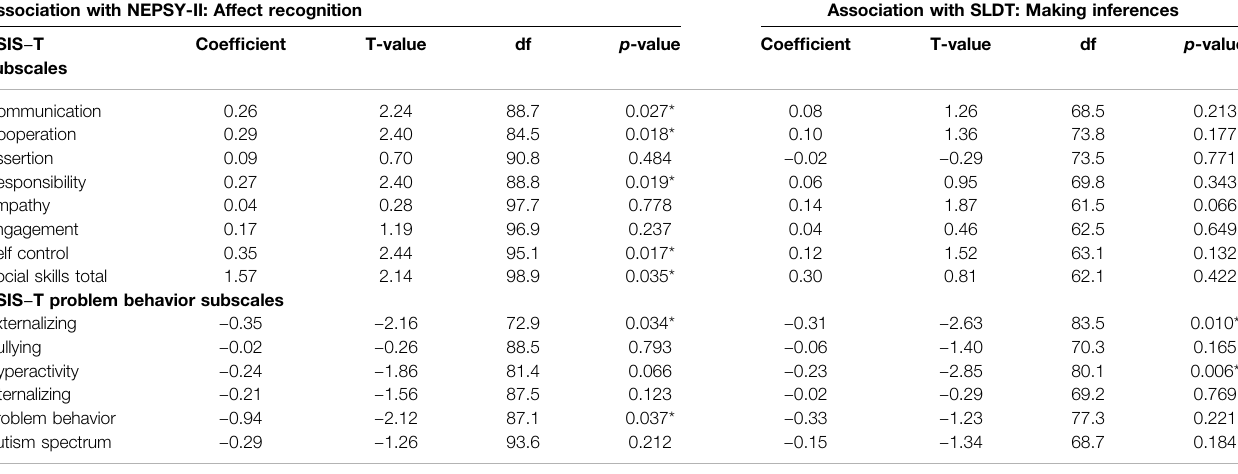
TABLE2| AssociationbetweenTeacherReportandBaselineMeasuresofSocialCompetency.Testsofregressioncoef fi cients,SSIS-Tsub-scaleassociationswithNEPSY- II (left) and SLDT (right).